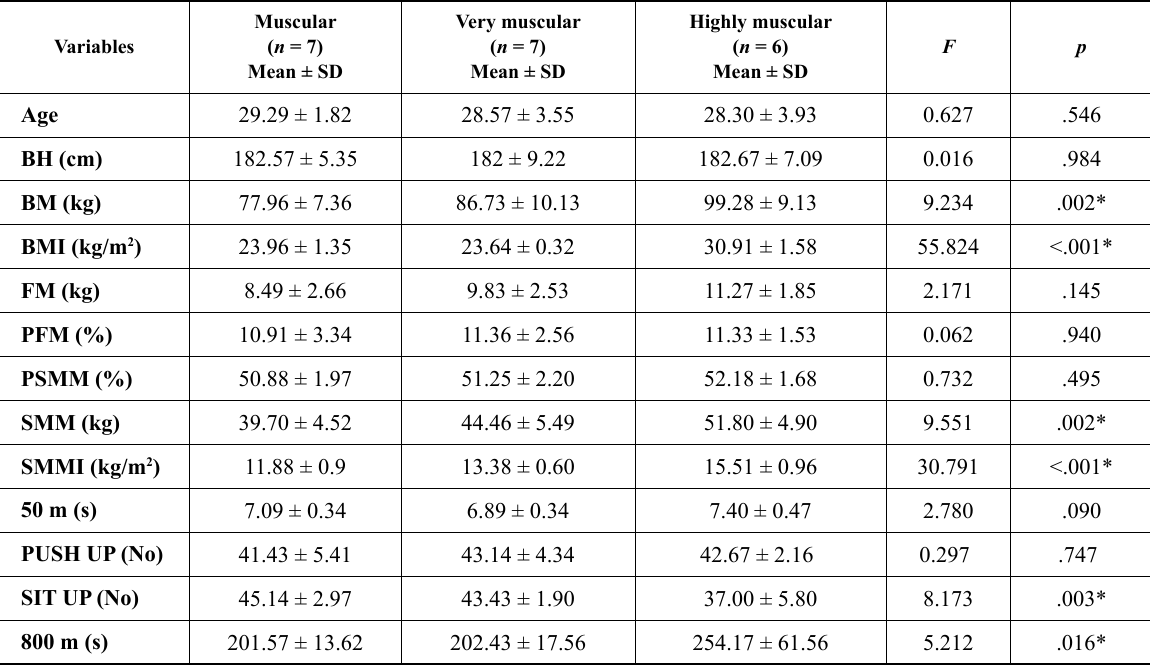
Table. Descriptive statistics for mean and standard deviation for each group, with the ANOVA values for F and p